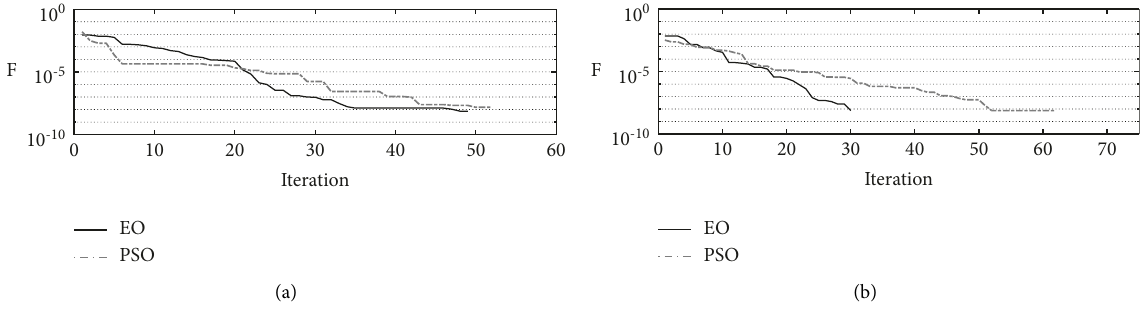
Figure 11: Convergence rates of EO and PSO for the cantilever beam; (a) using 1 mode, (b) using 5 modes. Table 7: Damage scenario for the 15-element cantilever beam.